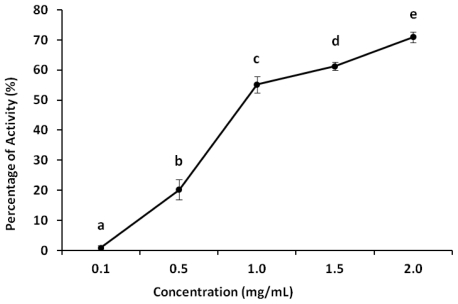
Chelating effect of xylan on ferrous ions. Data are expressed as means ± standard deviation. a,b,c,d,e Different letters indicate a significant difference between xylan concentrations by one-way Anova followed by Student-Newman-Keuls test (p < 0.05).